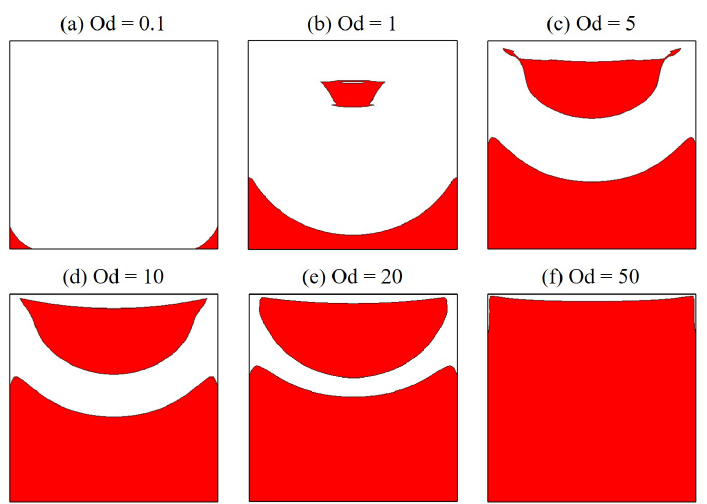
Figure 11. Solid-like zones ( ˙ γ ≤ 0.001 s − 1 ) as the red areas produced by the polymer flow in a square cavity at various Od .